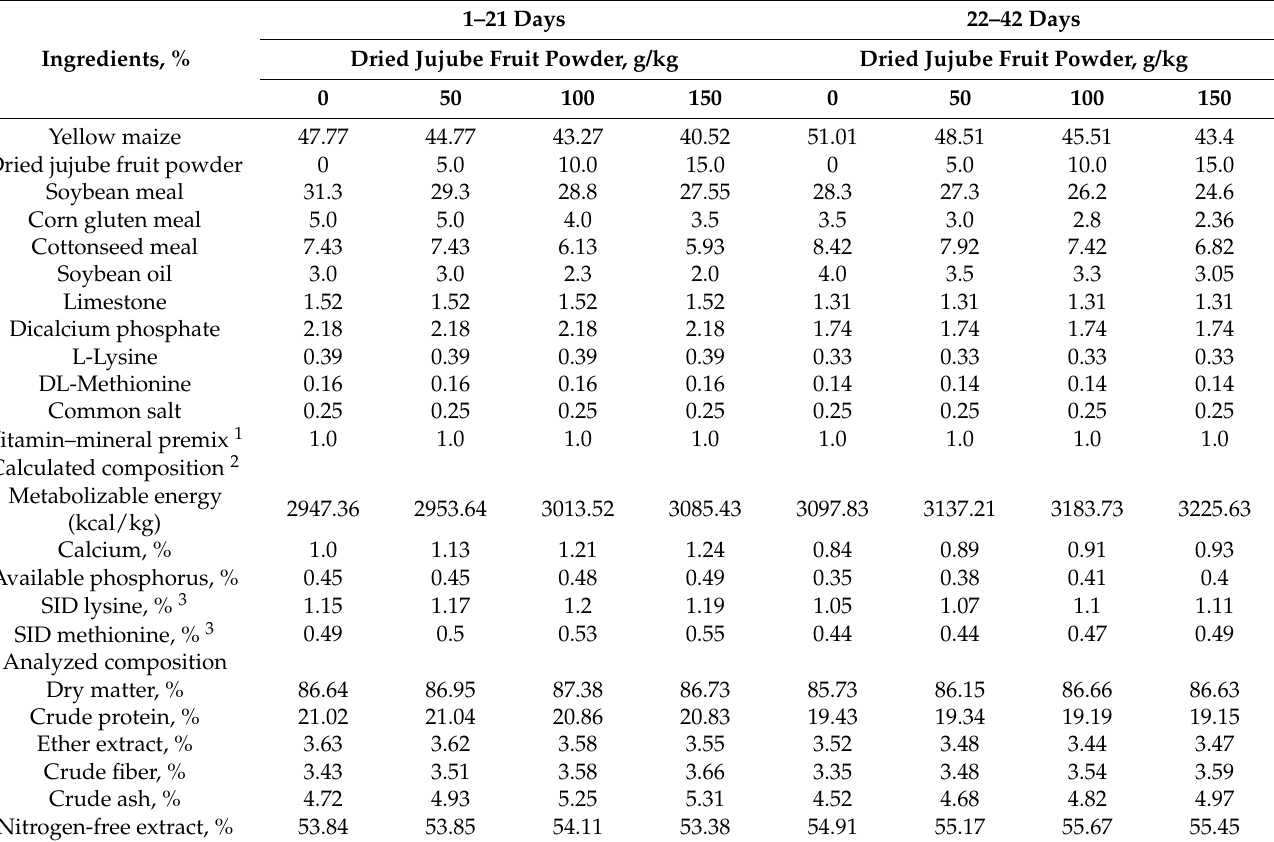
Table 1. Ingredients and chemical composition of the experimental